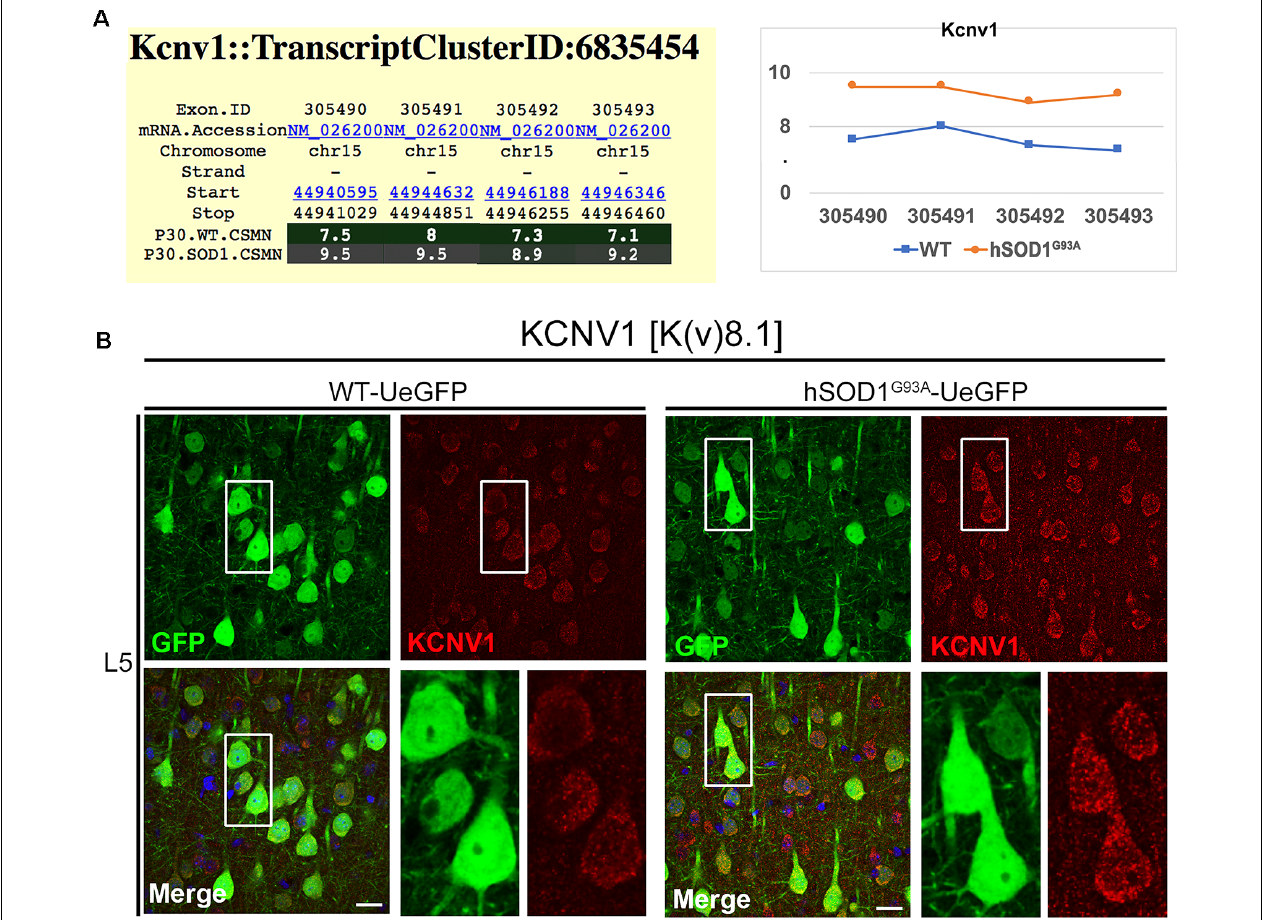
FIGURE 7 | KCNV1 expression levels are increased in diseased CSMN. (A) Gene expression analysis of Kcnv1. Expression values for each exon are plotted to the right. (B) Representative images of Kcnv1 expression in L5 motor cortex of WT-UeGFP (left) and hSOD1 G93A -UeGFP (right). CSMN (green) and Kcnv1 (red); insets are enlarged in the bottom right panels. Scale bar: 20 µ